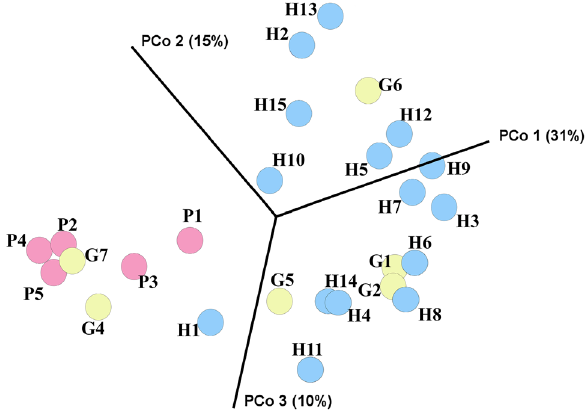
Figure 4. Plot of Principal Coordinate Analysis (PCoA) analysis of oral microbiota composition in periodontitis-osteomyelitis (P), gingivitis (G), and healthy (H)